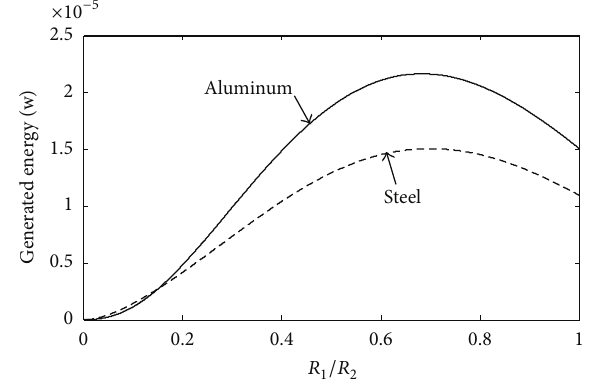
Figure 4: Effect of piezoelectric thickness on generated energy in the case of simple support (Section 2.1).